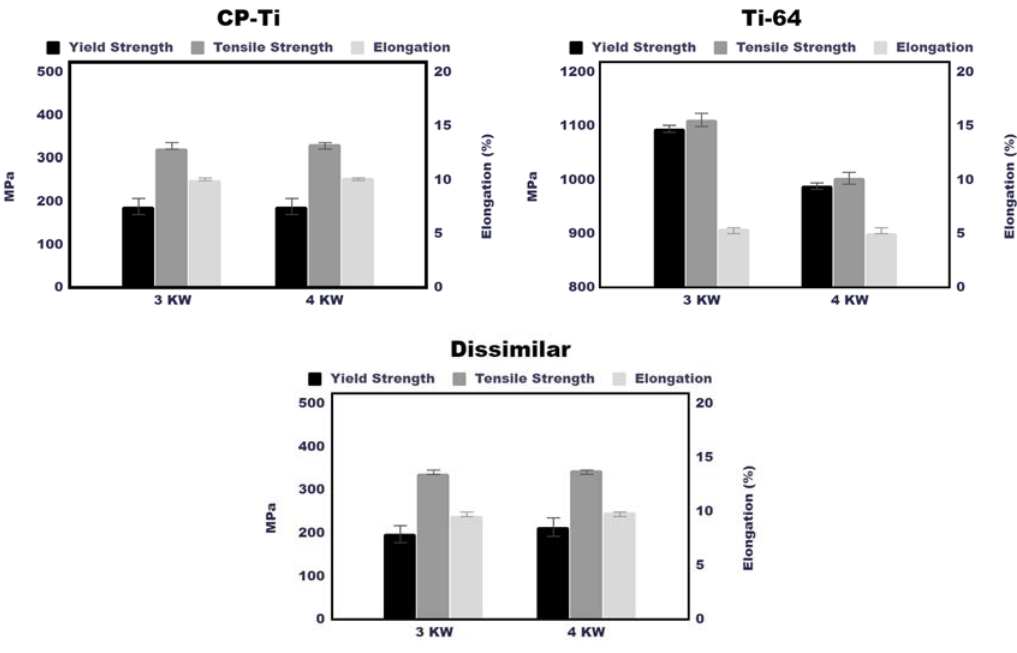
Figure 7. Comparison of mechanical properties for joints welded by 3 and 4 kW laser power.